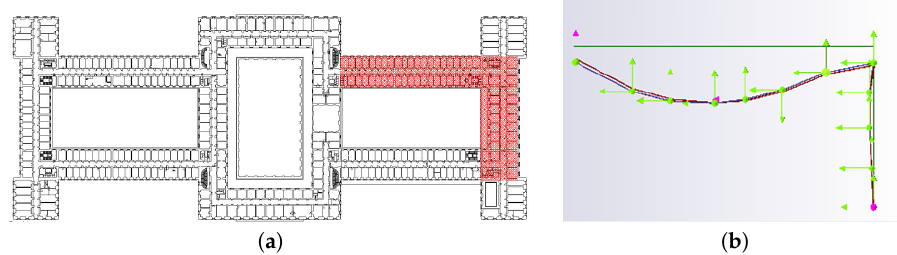
Figure 13. ( a ) building portion affected by the dynamic tests of the campaign 1—second floor. First vibrating mode: natural frequency f = 1.54 and ( b ) modal shape in the x − z